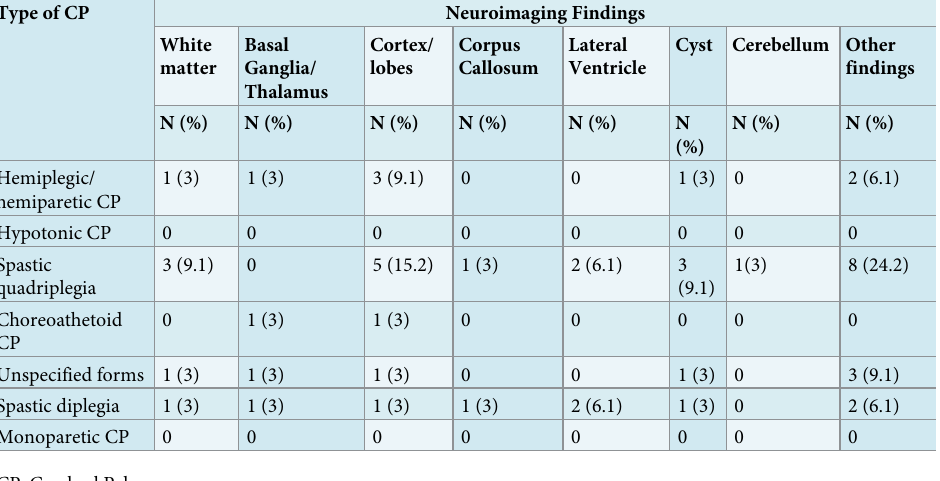
Table 4. Distribution of Neuroimaging findings based on CP type from January 2016 to August